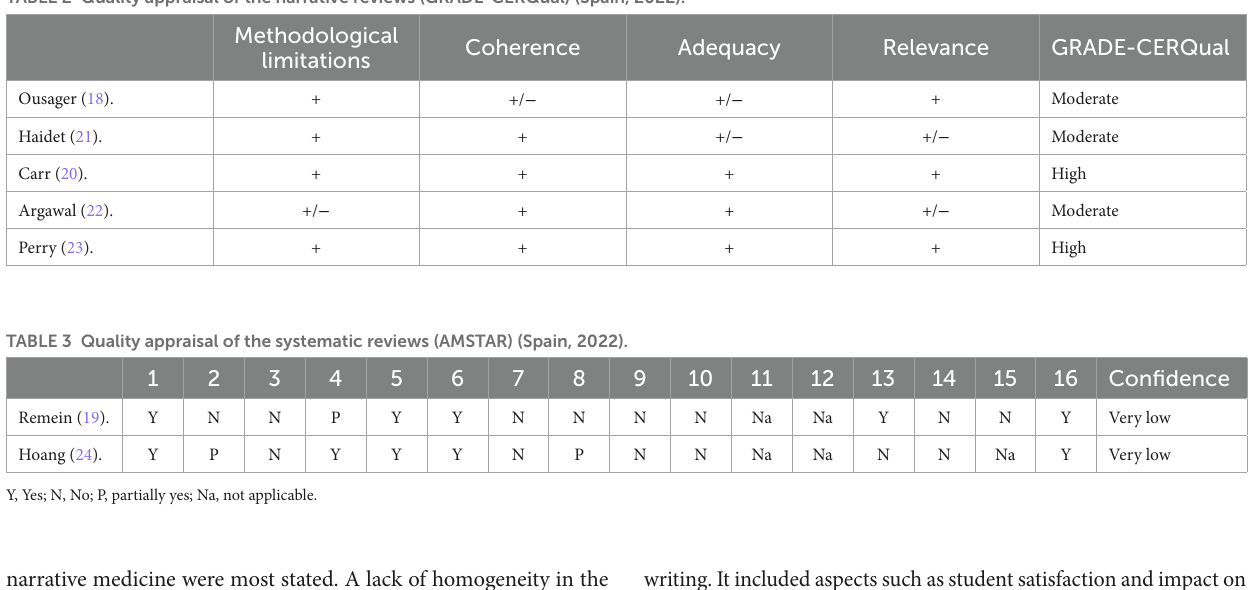
TABLE 2 Quality appraisal of the narrative reviews (GRADE-CERQual) (Spain, 2022).